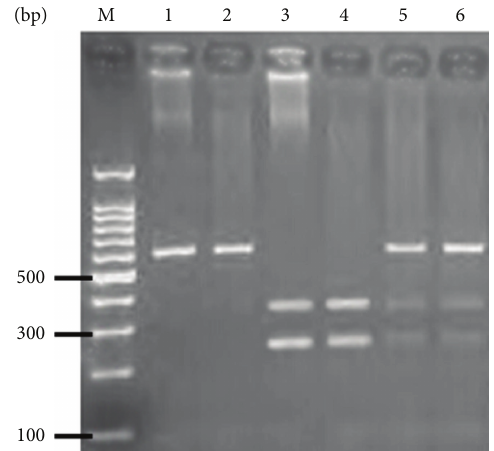
Figure 1: The XRCC1 Arg399Gln locus was amplified by PCR and PCR products were digested with Msp I to detect the 3 possible genotypes. Lane M : 100bp DNA Marker I; Lanes 1-2 , Gln/Gln; Lanes 3-4 , Arg/Arg; Lanes 5-6 ,